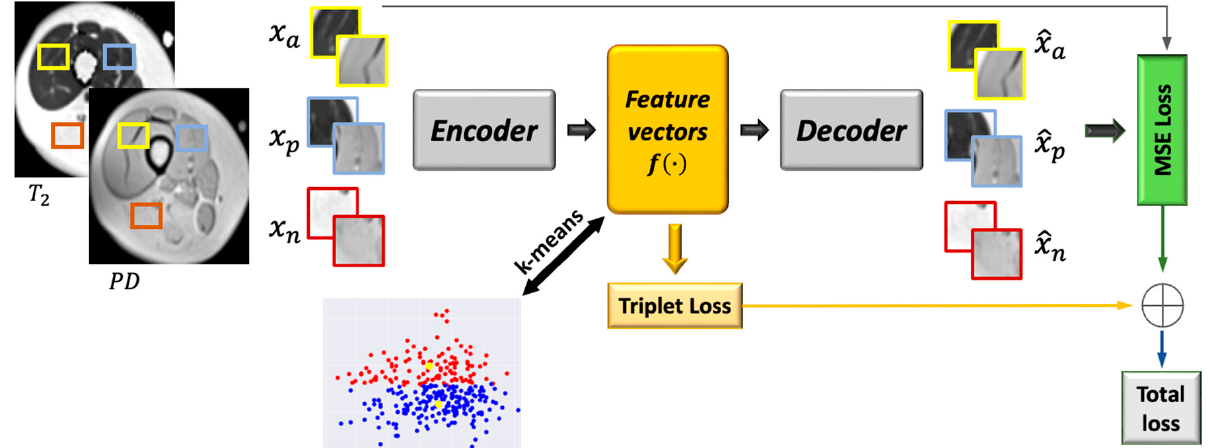
Figure 4. Integration of deep convolutional auto-encoder and triplet loss with k-means. See text for a more elaborate description of the network